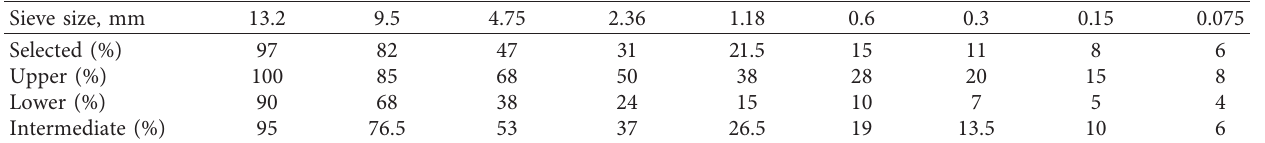
Table 2: Gradation of aggregate for